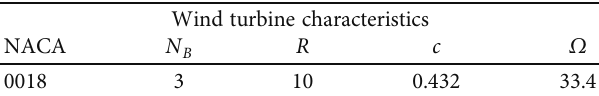
Figure 1: Cells located inside the hollow cylinder. The velocity components of each cell are passed to the stand-alone actuator cylinder model of the actuator cylinder class of the actuator- cylinder simpleFoam Table 1: Current turbine used throughout this work. N number of blades, R is the radius, c is the chord, and Ω is the rotational speed in rpm.